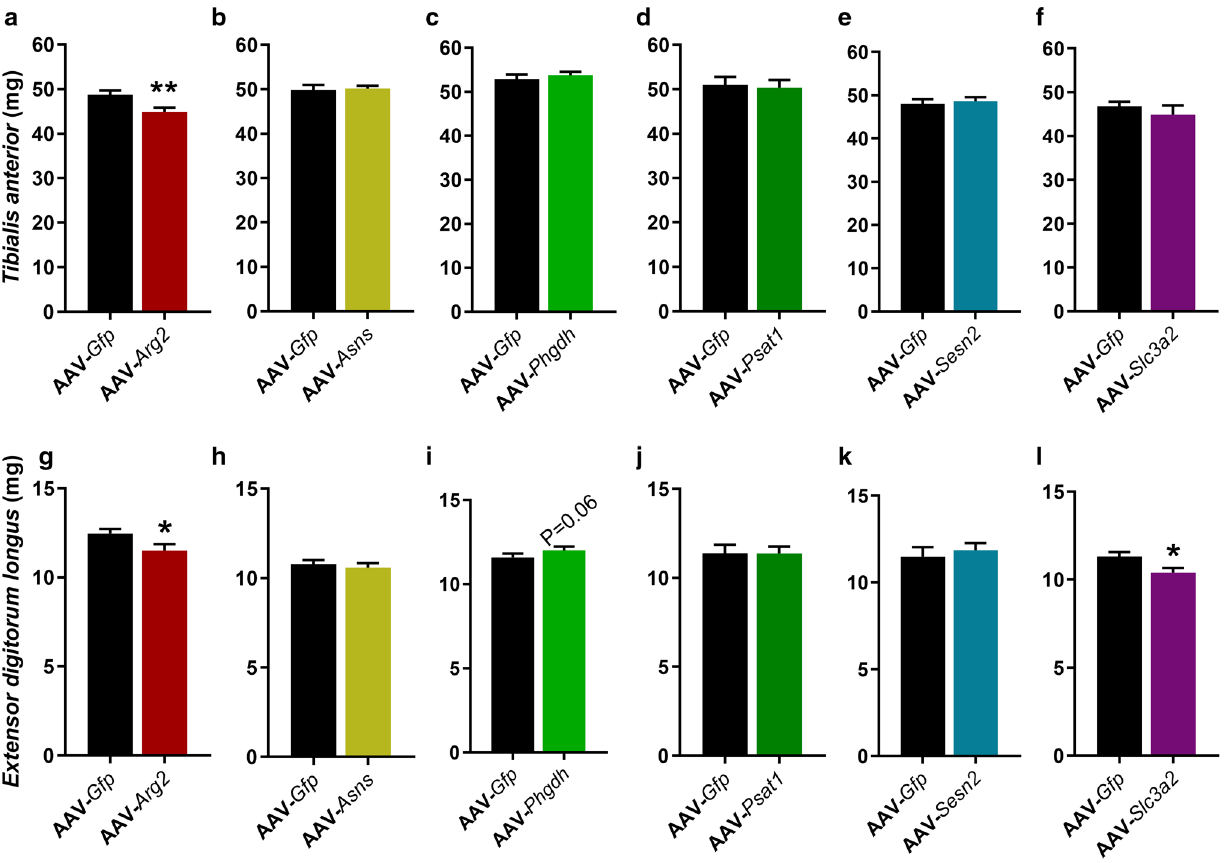
Figure 3. Effect of AAV-mediated overexpression of genes associated with an integrated stress response (ISR) on absolute muscle weights. Adeno-Associated Virus 1 (AAV) particles containing a gene of interest (GOI) were injected into mouse Tibialis Anterior (TA) muscle and a GFP control sequence alone (AAV- Gfp ) into the contralateral TA, then maintained in their home cage for 28 days. GOI included Arginase-2 (AAV- Arg2 ), Asparagine synthetase (AAV- Asns ), Phosphoglycerate Dehydrogenase (AAV-PHGDH), Phosphoserine Aminotransferase-1 (AAV- Psat1 ), Sestrin-2 (AAV- Sesn2 ) and Solute Carrier family 3 member 2 (AAV- Slc3a2 ). Data shown as Means (n = 8, except AAV- Sesn2 n = 10) ± SEM for absolute TA ( a – f ) and Extensor Digitorum Longus (EDL; g – l ) muscle weights. *( P < 0.05), **( P < 0.01) indicate significantly different from contralateral control limb injected with AAV- Gfp